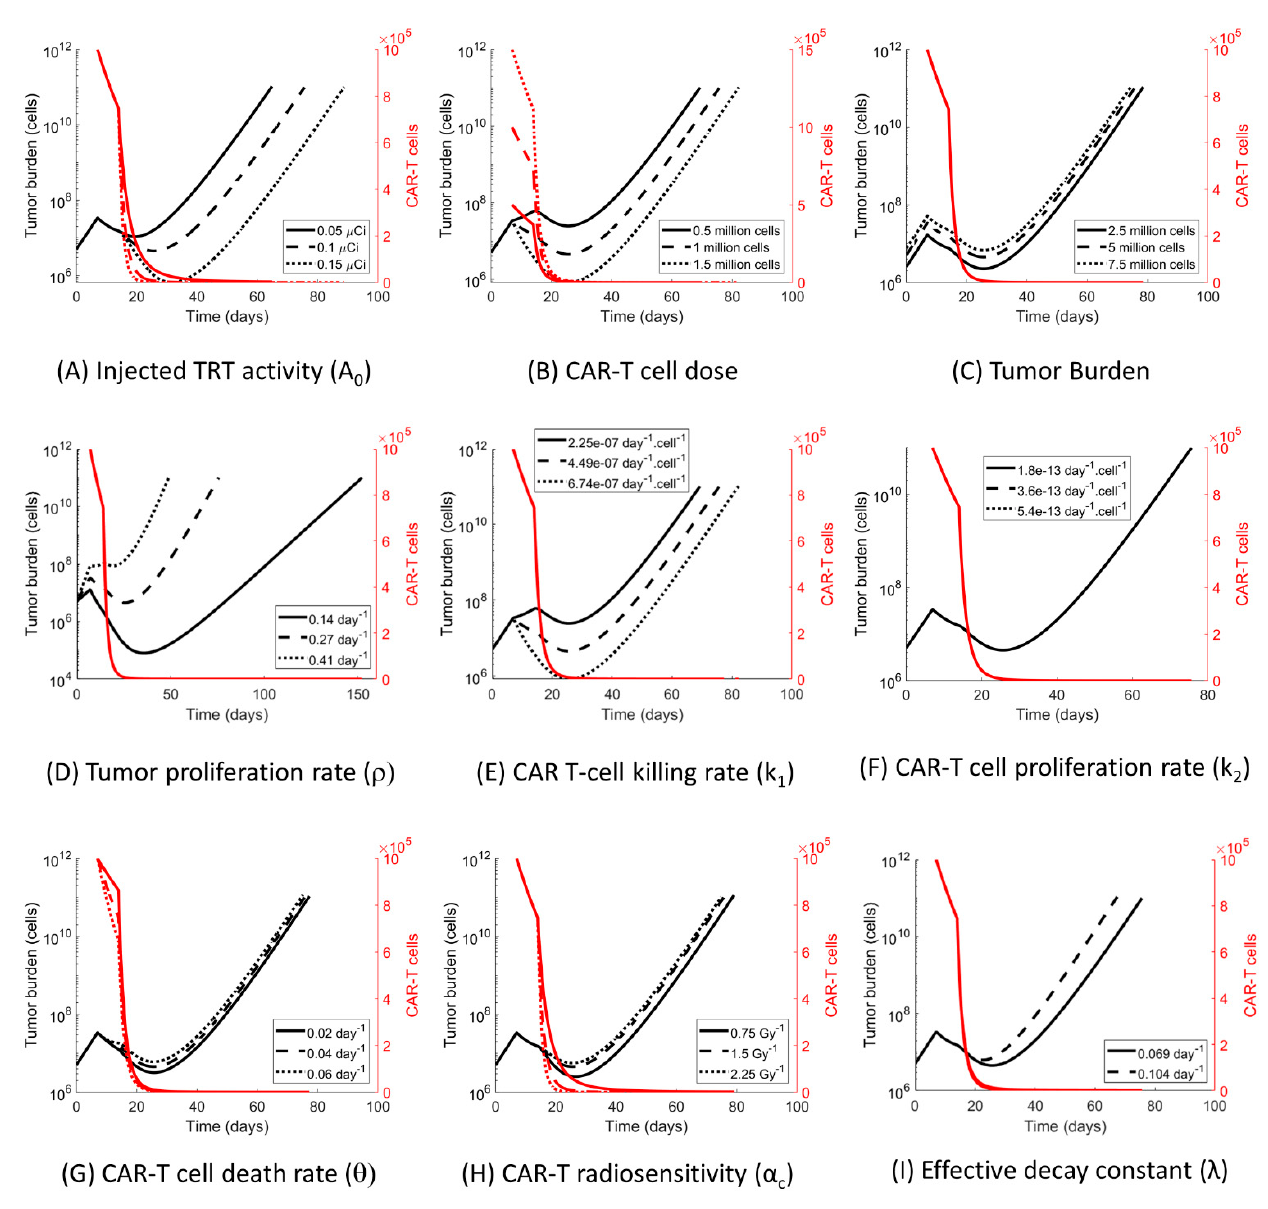
Figure 5. Sensitivity analysis. Impact of the model parameter variation (+/ − 50%) on the tumor growth curves for the CAR-T (day t = 7) followed by the TRT (day t = 14) therapy for 9 model parameters shown and labeled in Figure subpanels ( A – I ). The variation in the tumor proliferation ( D ) has the largest impact on the tumor growth response to combination ther- apy.